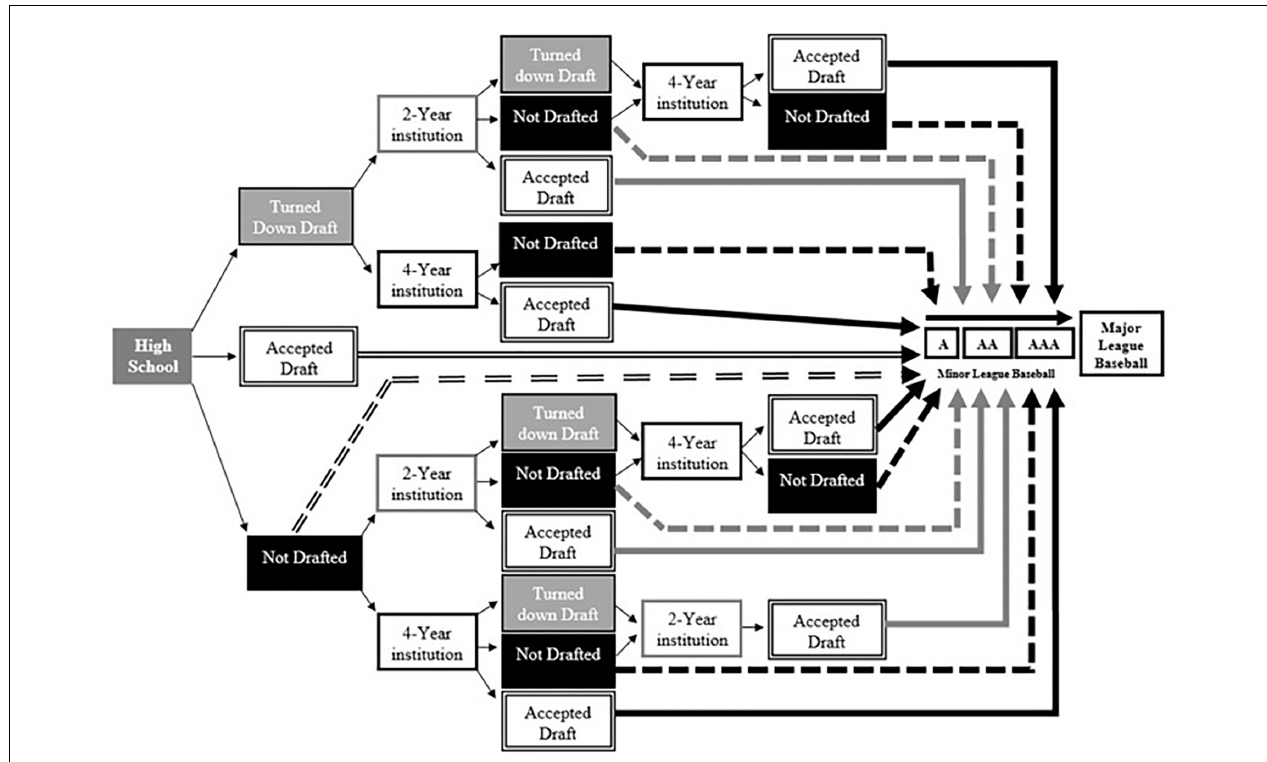
FIGURE 1 | Schematic illustration of the developmental pathways to MLB. Solid arrows represent players signing after being drafted whereas dashed arrows represent players signing as undrafted free agents. Degree of shading and design of arrow pointing to Minor League Baseball represents last institution attended. Single black line = 4 year institution, single gray line = 2 year institution, and double black line = high school. Not Drafted = players were not selected in the draft by a professional team. Turned down Draft = players were selected in the draft by a professional team but elected to turn down the contract associated with their selection. All players are draft eligible after high school graduation, and players at 4 year institutions are draft eligible 3 years after enrolling or after their 21st